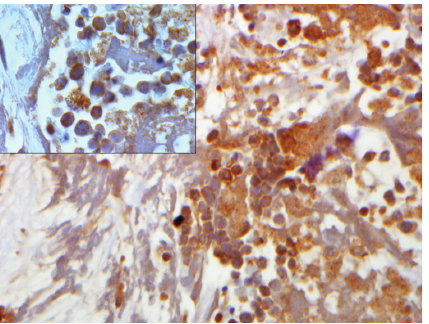
Figure 5: Immunohistochemical stain myeloperoxidase (MPO) shows positive myeloid cells, magnification 400x (insert